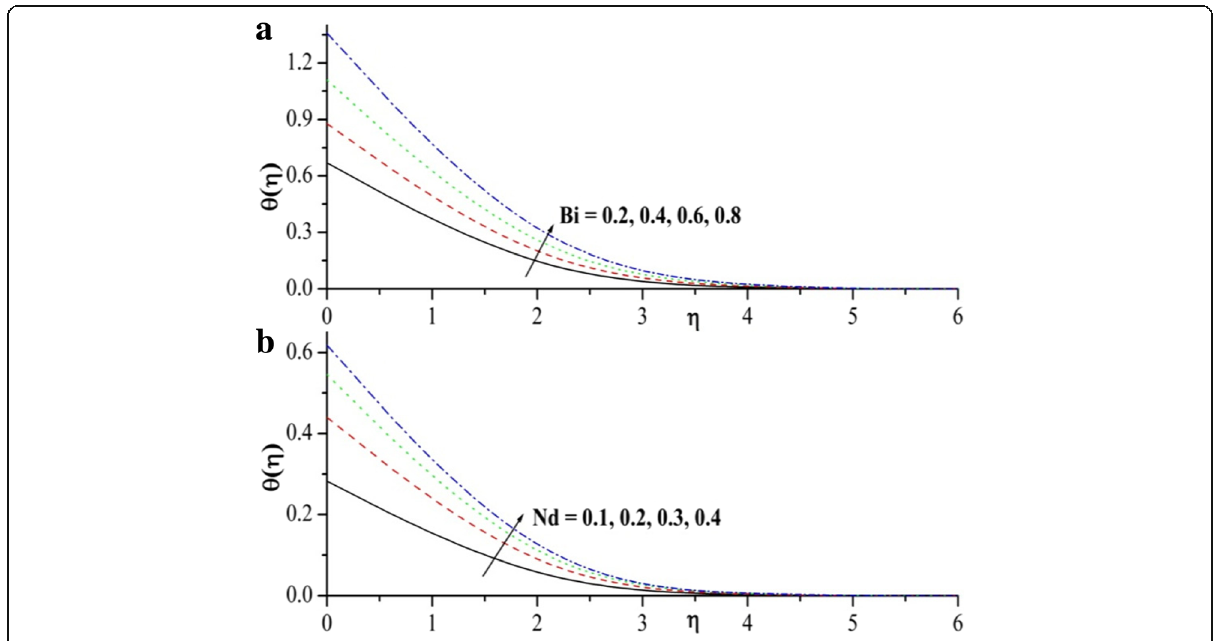
Fig. 13 a , b Temperature profiles for variable values of Bi and Nd,